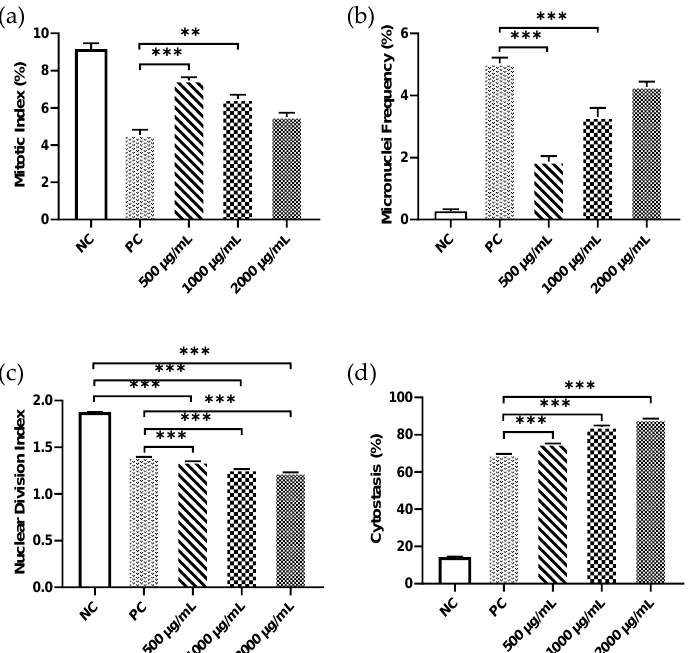
Table 1. Frequency of NPB, NBUD, and different chromosomal aberrations, such as chromosomal breaks, dicentric chromosomes, fragments, and rings in lymphocytes, treated with different con- centrations of PSNPs after 48 h of exposure.